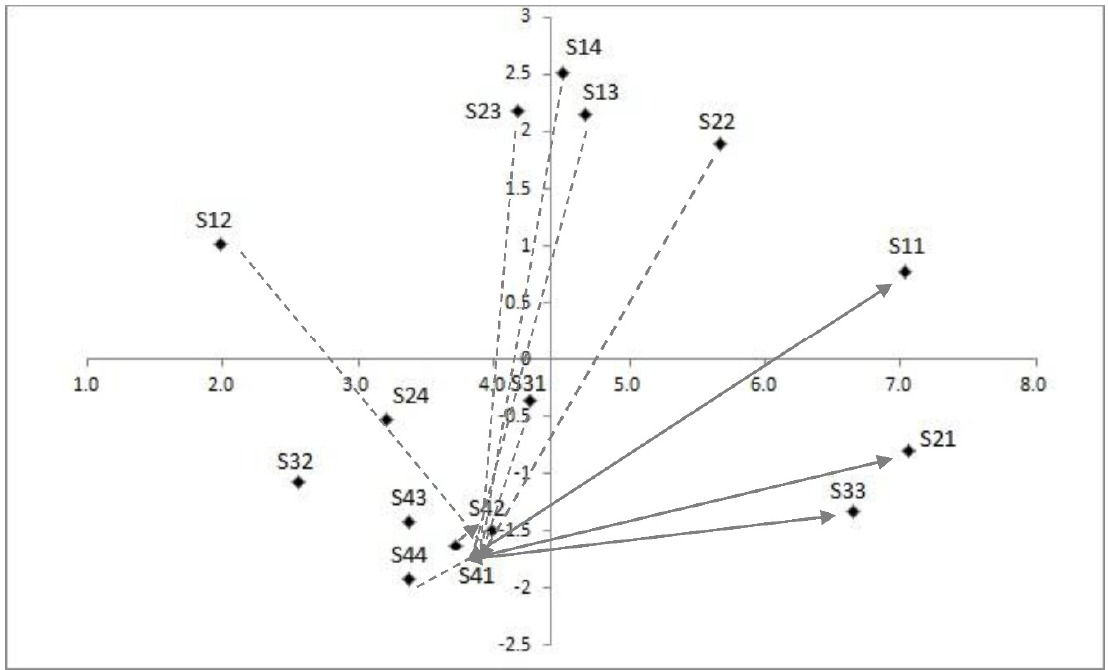
Figure A12. Casual Diagram between S41 and Other